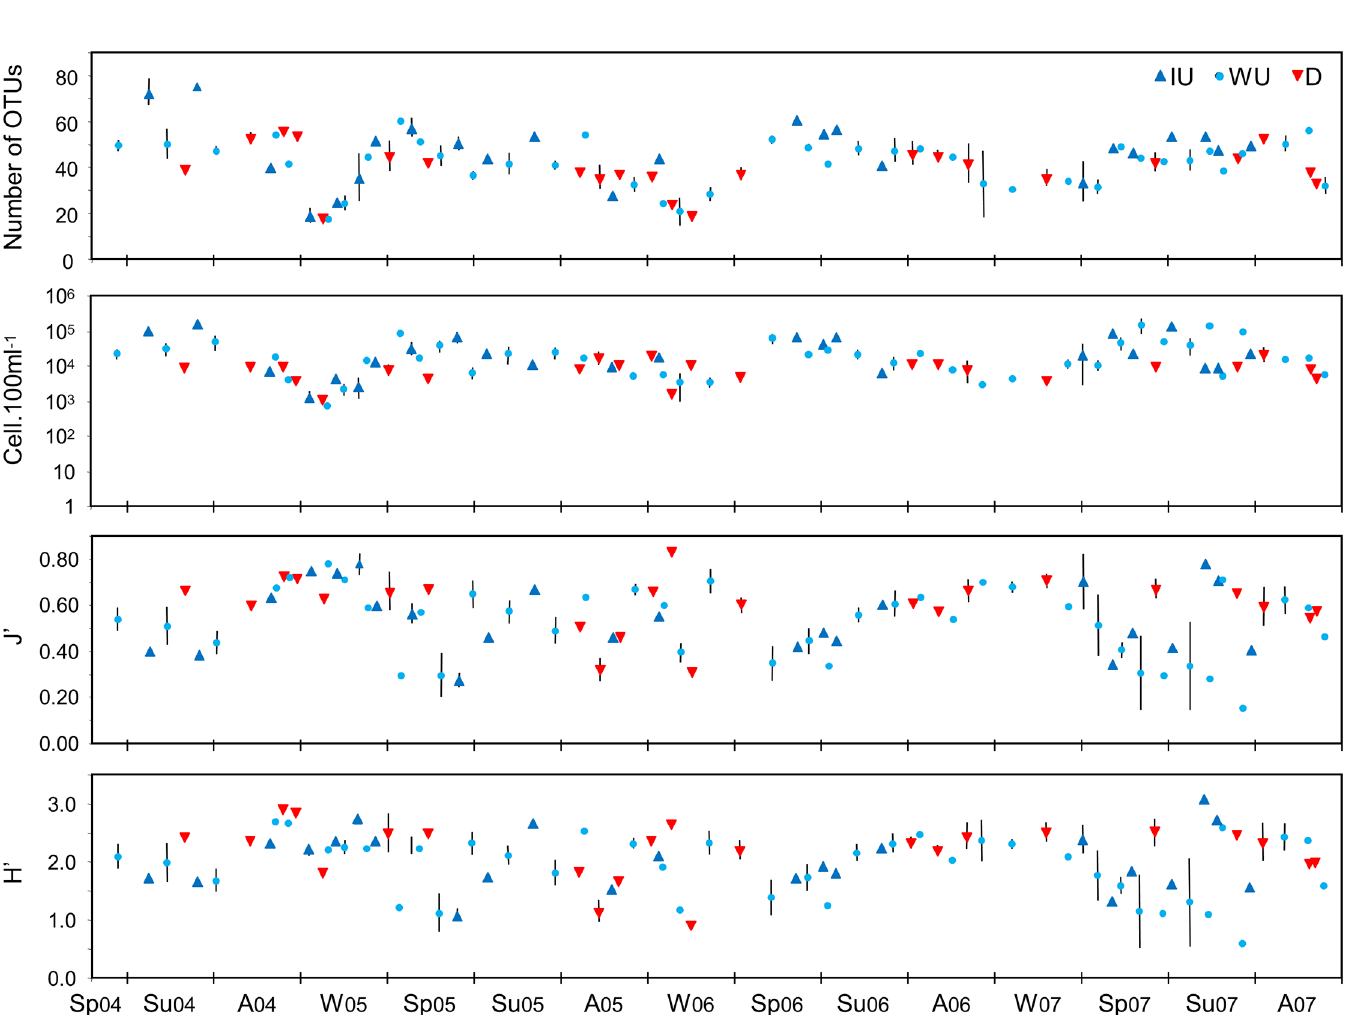
Fig 6. Community structure descriptors of the phytoplankton assemblage throughout the study period. Values shown are the averages and respective standard error bars for the different periodsof upwellingconditions. IU: intenseupwelling; WU: weak upwelling;D: downwelling.